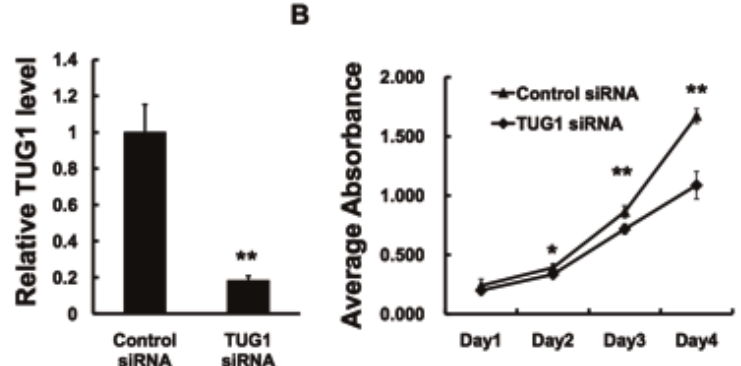
Figure 2: TUG1 promotes tumor proliferation in U2OS cells. (A) U2OS cells were transfected with control siRNA or lncRNA TUG1 siRNA. In 48h, the cells were harvested for examining knockdown effect. (B) U2OS cells were transfected with control siRNA or lncRNA TUG1 siRNA. In 24h, cells were trypsinized and seeded into four 96-well plates at a density of 3×10 3 cells for MTT assay as described under Materials and Methods. Data are expressed as the mean ± s.d. of the experiments performed in triplicate. * P <0.05, ** P